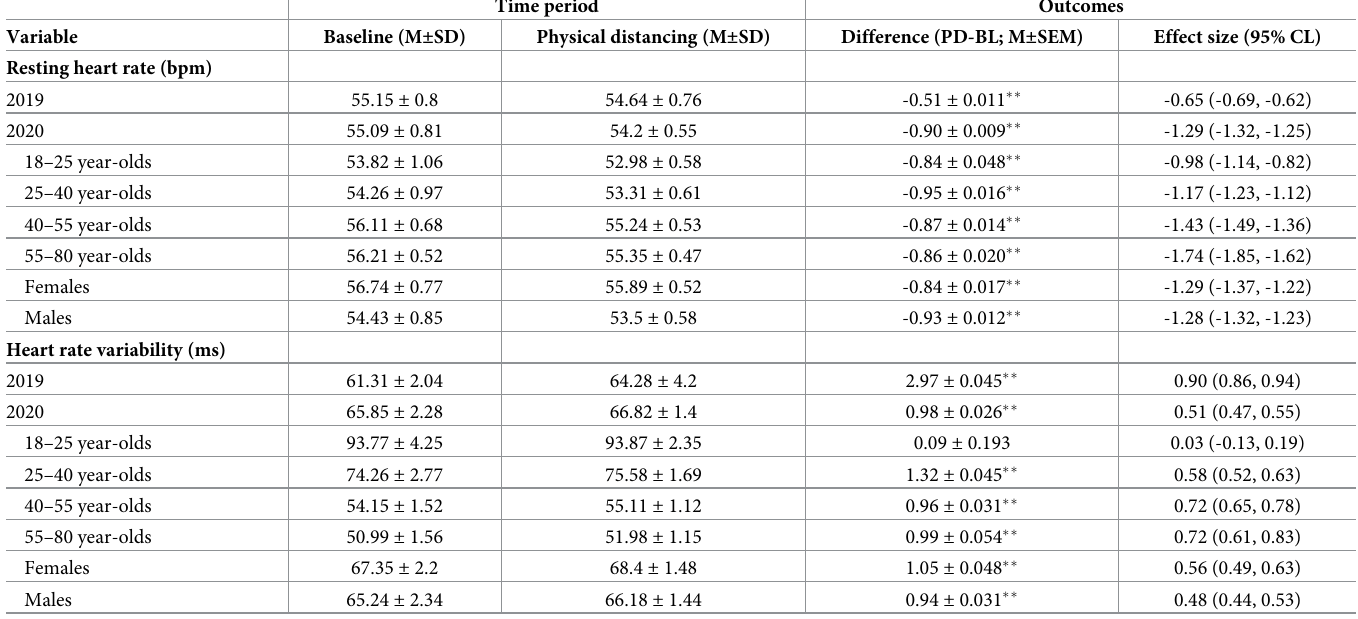
Table 5. Cardiovascular outcomes as a function of time